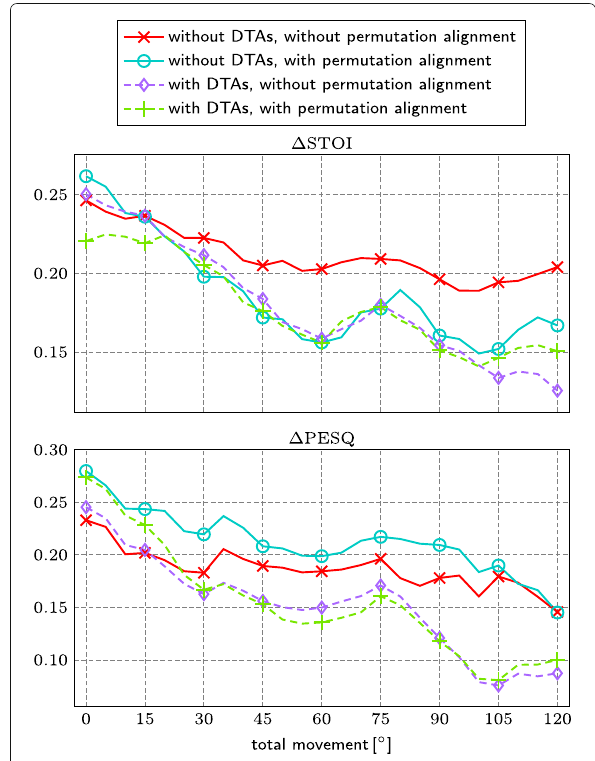
Fig. 12 Subset of the results from Fig. 11 (proposed initialization, omit STAs). The performance of the approach with DTAs deteriorates with an increasing length of the speaker trajectory due to the lack of data to determine optimal parameters for all direction specific mixture